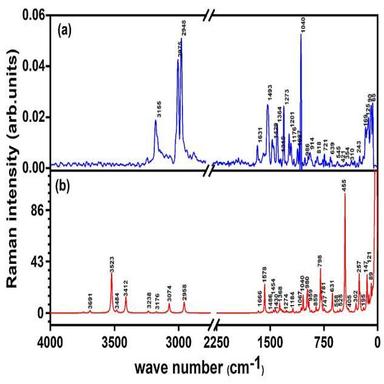
Comparison of (a) observed and (b) simulated Raman spectra of the PCOH.